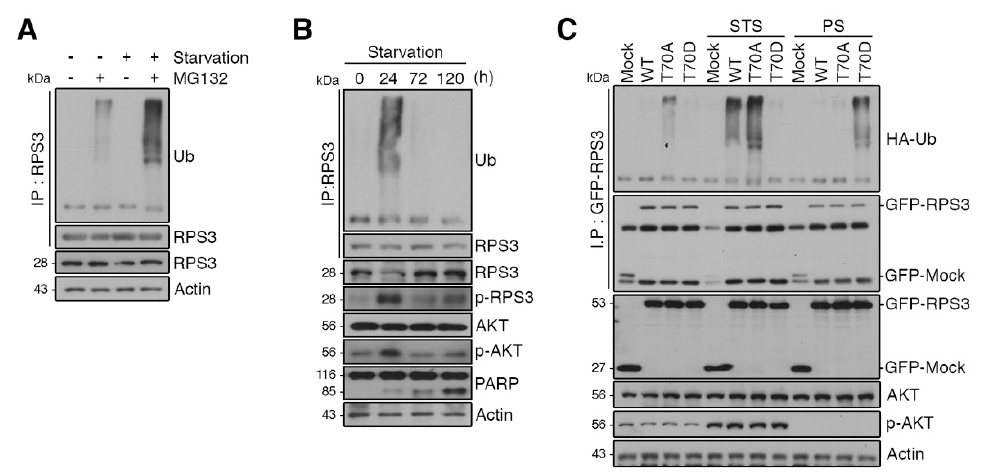
Figure 3. RPS3 is regulated by the ubiquitin–proteasome system (UPS) under starvation conditions. ( A ) Cortical neurons were incubated with or without the proteasome inhibitor MG132 and/or B27 serum starvation for 2 h. The cell lysates were subjected to immunoprecipitation with the anti-RPS3 antibody. Ubiquitinated RPS3 levels were detected by immunoblotting with an anti-Ub antibody. ( B ) Brain lysates of starved mice (0, 24, 72, and 120 h) were subjected to immunoprecipitation with the anti-RPS3 antibody. Ubiquitination of endogenous RPS3 was measured by immunoblotting with the anti-Ub antibody. ( C ) GFP-RPS3 WT, T70A (a nonphosphorylatable mutant), T70D (a phosphorylation-mimetic mutant), or control vector were transfected into HEK 293T cells together with HA-Ub and incubated with or without FBS for STS (8 h) or PS (16 h). Starvation conditions for these HEK293 cells were determined by immunoblotting (Figure S2). Immunoprecipitation of the cell lysates was performed with an anti-GFP antibody to detect ubiquitination of transfected RPS3 WT, T70A, or T70D with an anti-HA